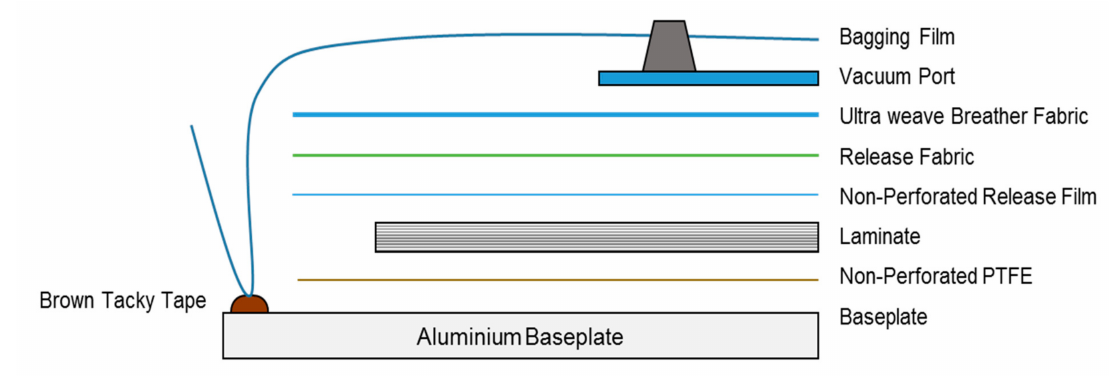
Figure 1. Schematic diagram of vacuum